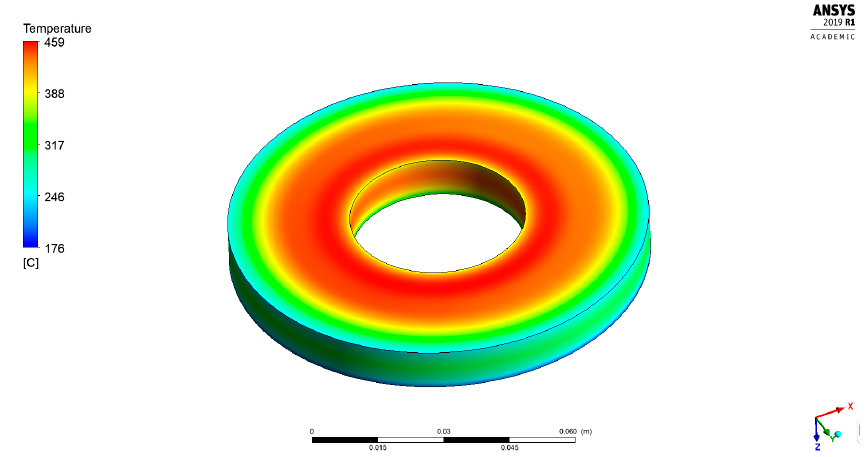
Figure 6. Temperature distribution after the time of 26.5 (s) of the hardening process.